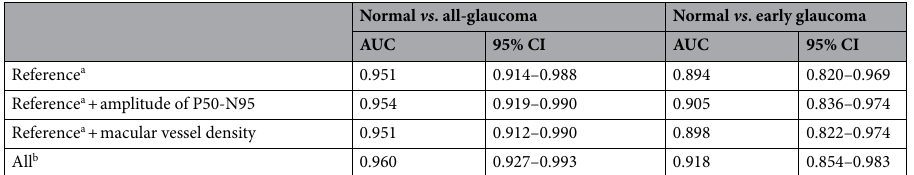
Table 4. Age-adjusted AUC values for the detection of glaucoma. AUC area under the curve, CI confidence interval, MD mean density. a MD + ganglion cell-inner plexiform layer thickness. b MD + ganglion cell-inner plexiform layer thickness + amplitude of P50-N95+ macular vessel